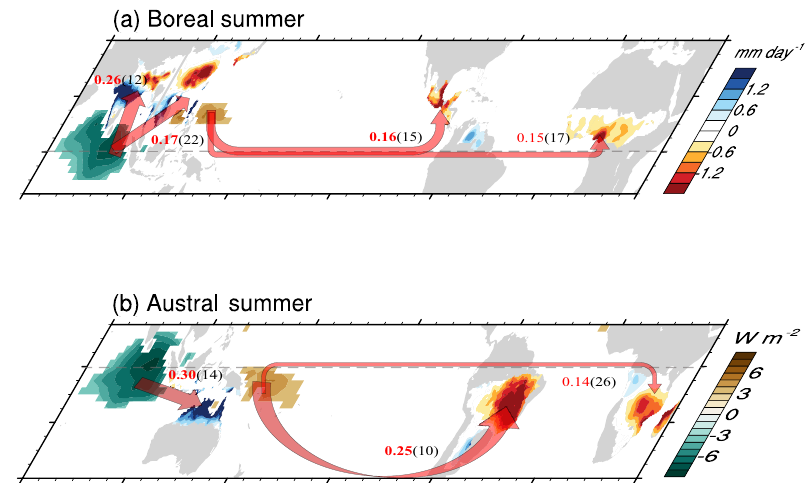
Fig. 6 Role of MJO in modulating the 20 – 70-day ISVs in individual summer monsoon regions. Red Arrows indicate lead correlations between MJO convective center in equatorial central Indian Ocean (or negative convective anomaly in tropical western Paci fi c) and the leading modes of 20 – 70-day ISVs over individual monsoon regions during a boreal summer and b austral summer. Shading over the ocean denotes the regressed OLR anomaly (W m − 2 ) onto the negative RMM2. The shading over land depicts the leading EOF pattern (mm day − 1 ) of each monsoon (Fig. 3b). The sign of the EOF in Fig. 3b is reversed when the maximum correlation coef fi cient is negative. The values in red indicate the maximum correlation coef fi cient, and the values in the bracket show the leading days. All correlations are signi fi cant at the 90% con fi dence level, except for the two African fractional variance of the ISV to daily variance (Fig. 1b) and higher contribution of the LFISV to the total ISV than in other regions (Table 2). In addition, the enhanced MJO convection over the central equatorial Indian Ocean tends to lead wet Southeast Asia and dry South China by 22 days. The dry anomaly over the tropical western Paci fi c leads the dry phase by 15 days over Mexico and by ten days over Brazil. These lead-lag correlations can be potentially used for the sub-seasonal prediction of each regional monsoon.